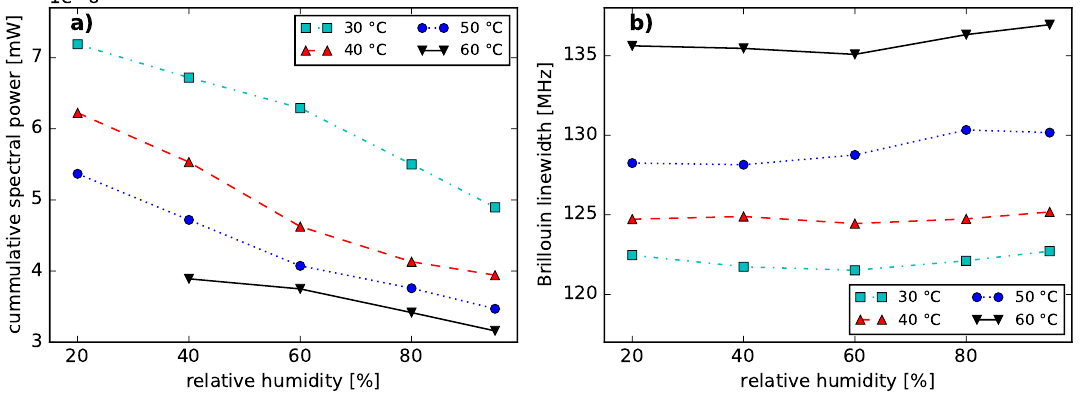
Figure 4. ( a ) Cumulative BGS power of the electrical signal as a function of relative humidity at specified temperatures. ( b ) Brillouin linewidth (full width at half maximum) as function of relative humidity at given